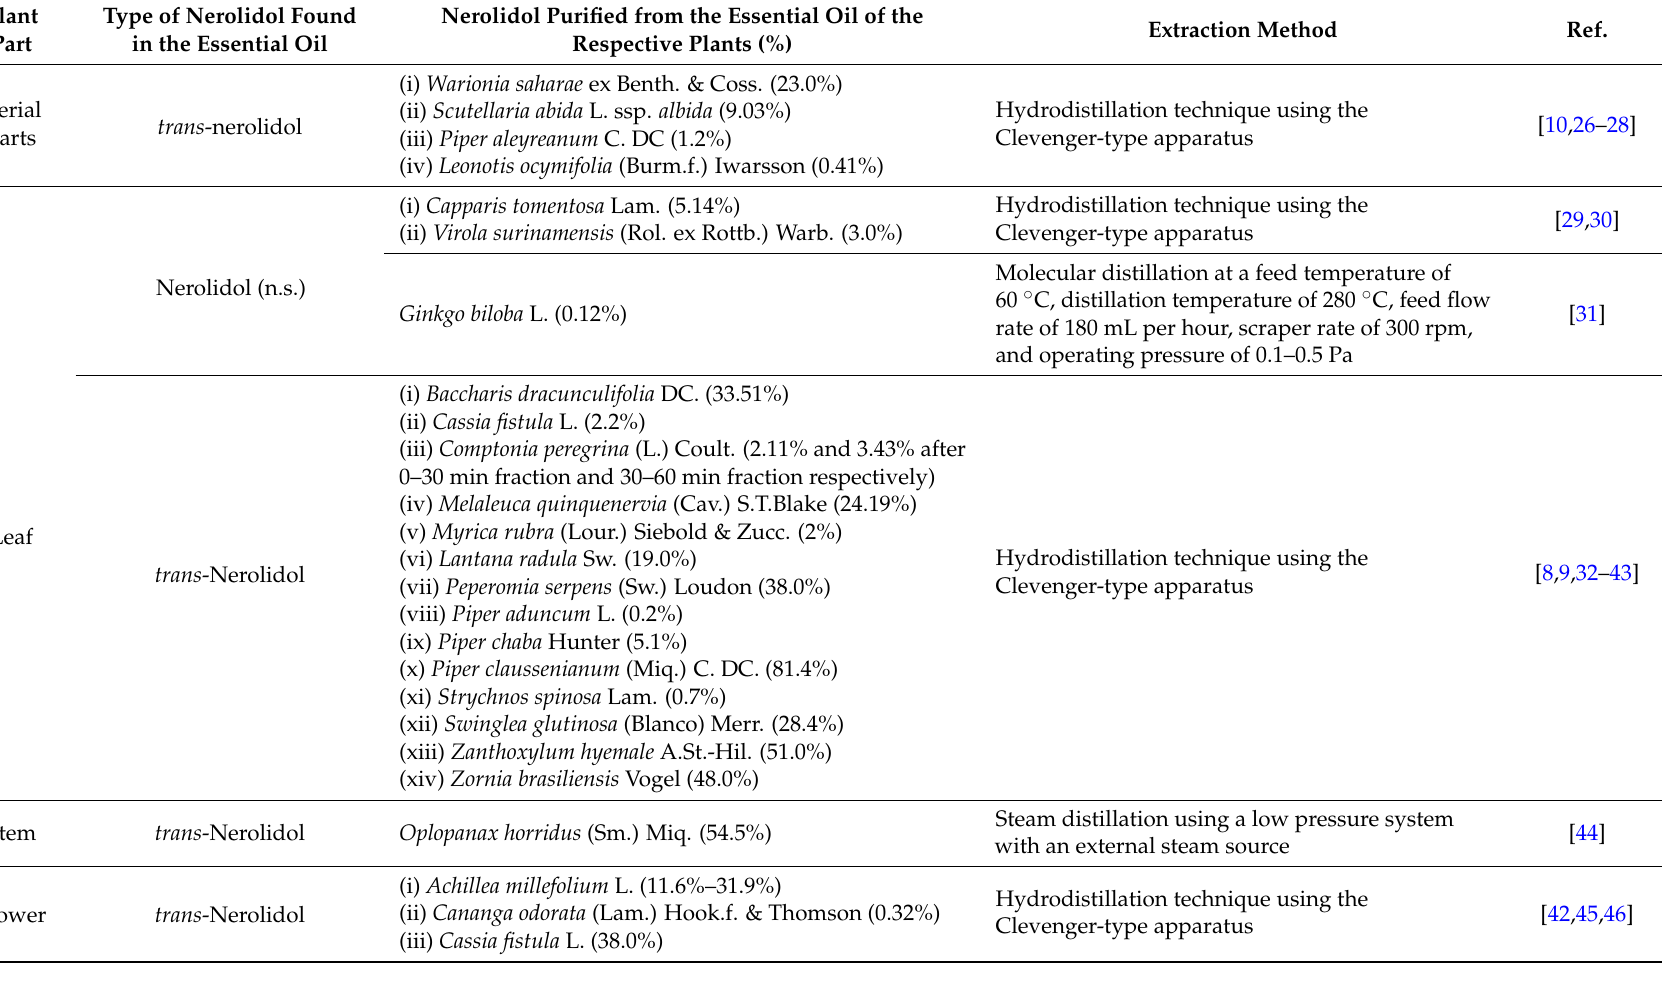
Table 2. Plant sources of nerolidol along with its percentage of nerolidol and extraction